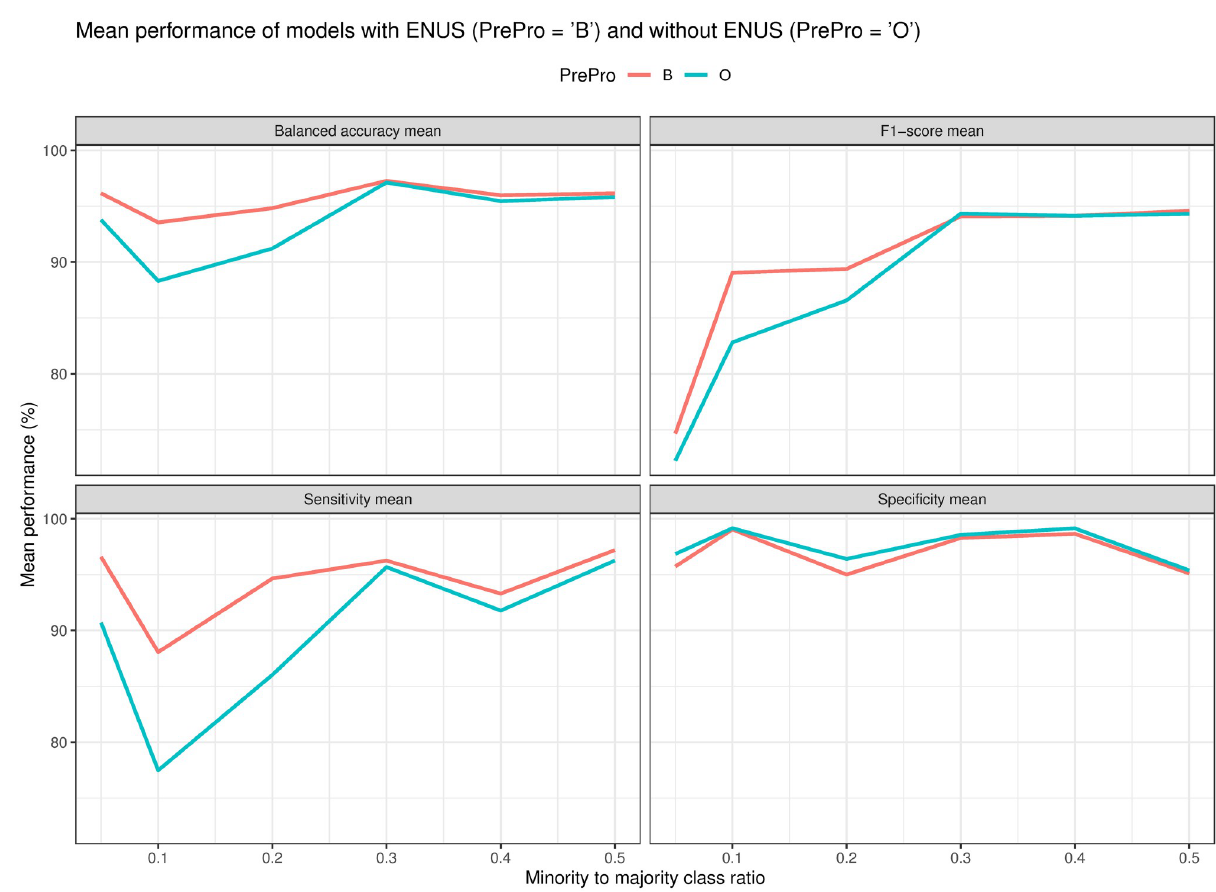
Fig 18. Mean performance of all models with different ratios of minority to majority classes. Models trained with balanced training data (PrePro = ‘B’) significantly improved compared to those trained with original data (PrePro = ‘O’), especially in the smaller range of the ratios.